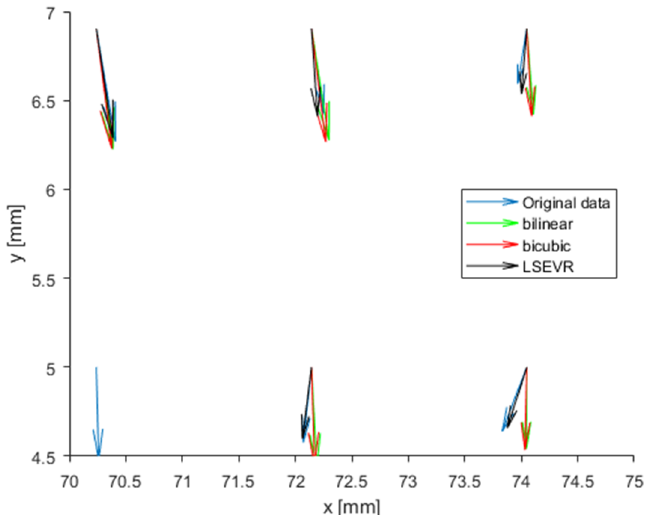
Figure 12. Comparison of performance of vector replacement with clumped sparse vectors.